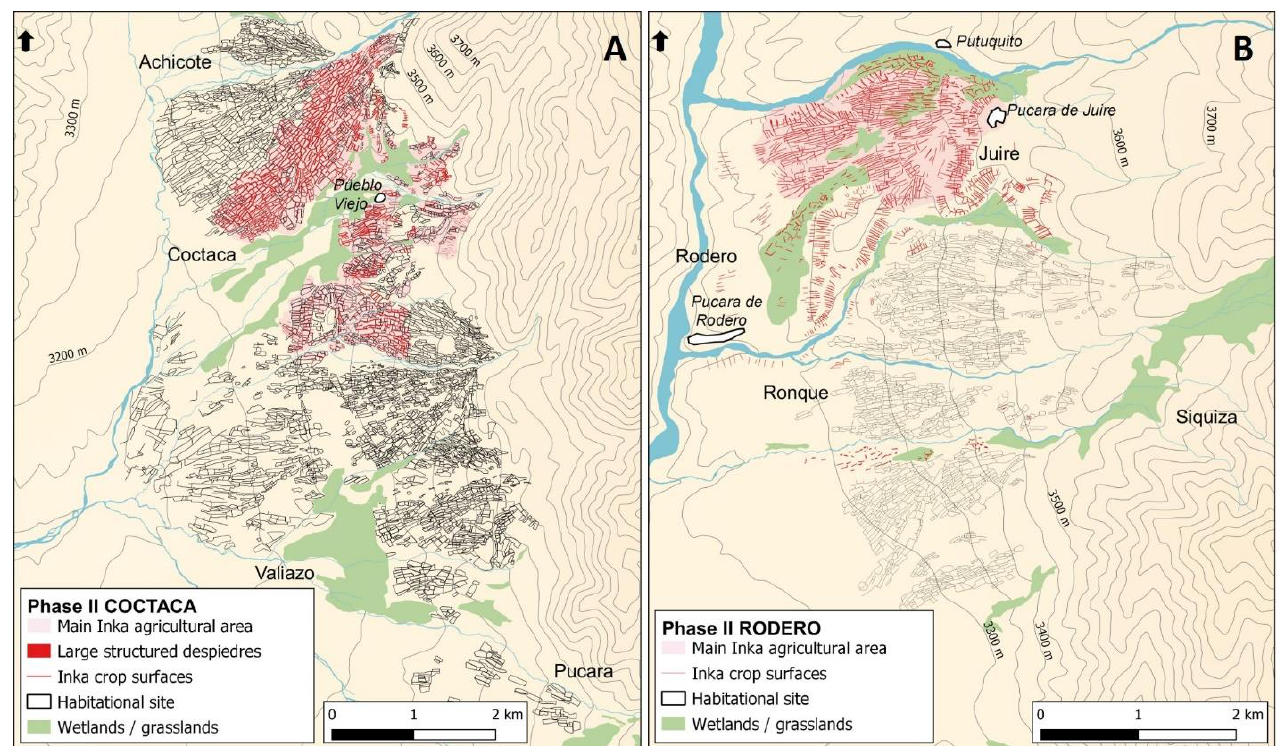
Figure 5. Main Inka agricultural sectors in ( A ) Coctaca and ( B ) Rodero.